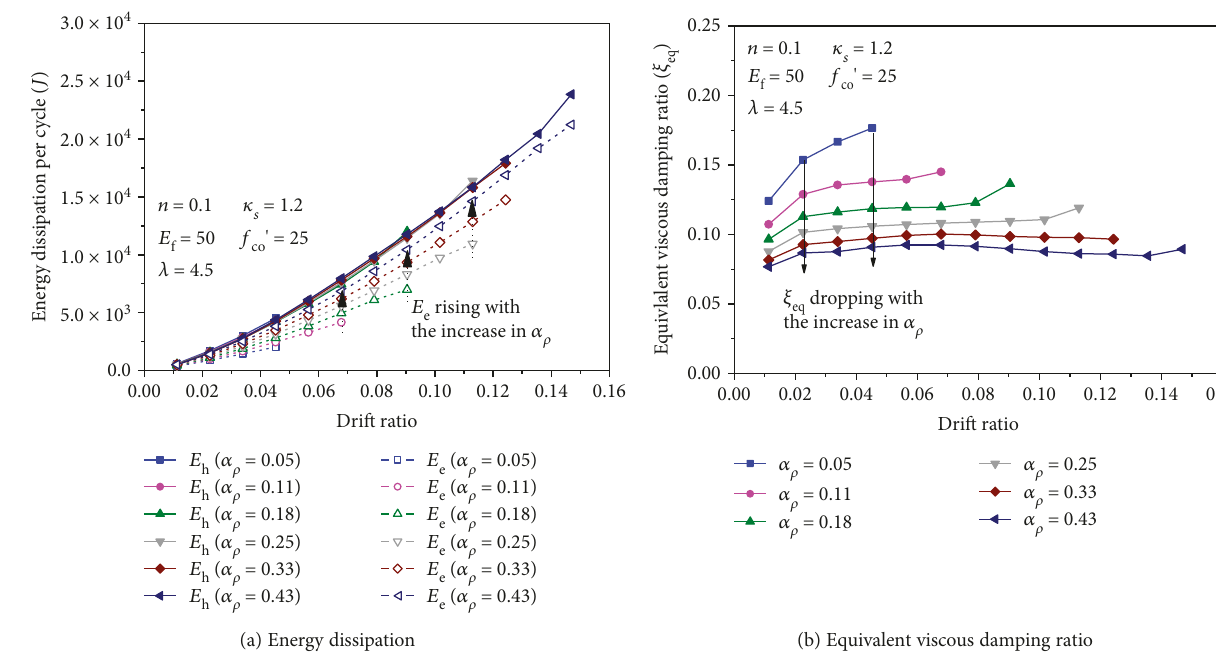
Figure 13: Variation of energy dissipation indicators with drift ratio along with α